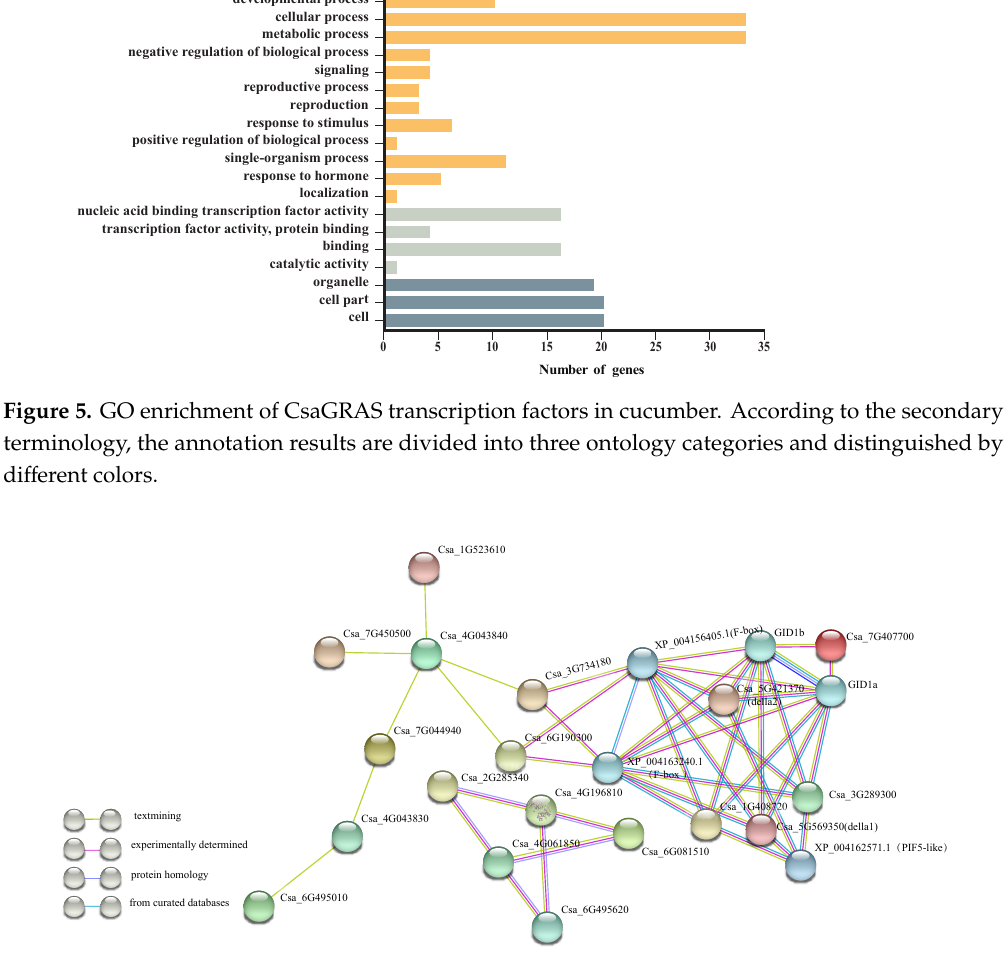
Figure 6. Interaction network among CsaGRAS families in cucumber. Specific protein interactions between GRAS transcription factors in cucumber were determined using String (https: // string-db. org / ) [43]. The colorful lines represent the confirmed way of